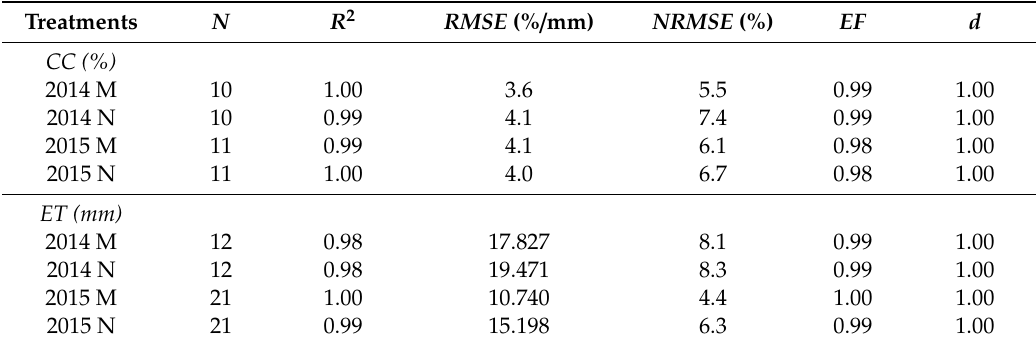
Table 3. Goodness-of-fit indicators between measurements and simulations for CC and accumulated evapotranspiration ( ET ) of seed maize for treatments with and without plastic film mulch (M and N) in 2014 and 2015.